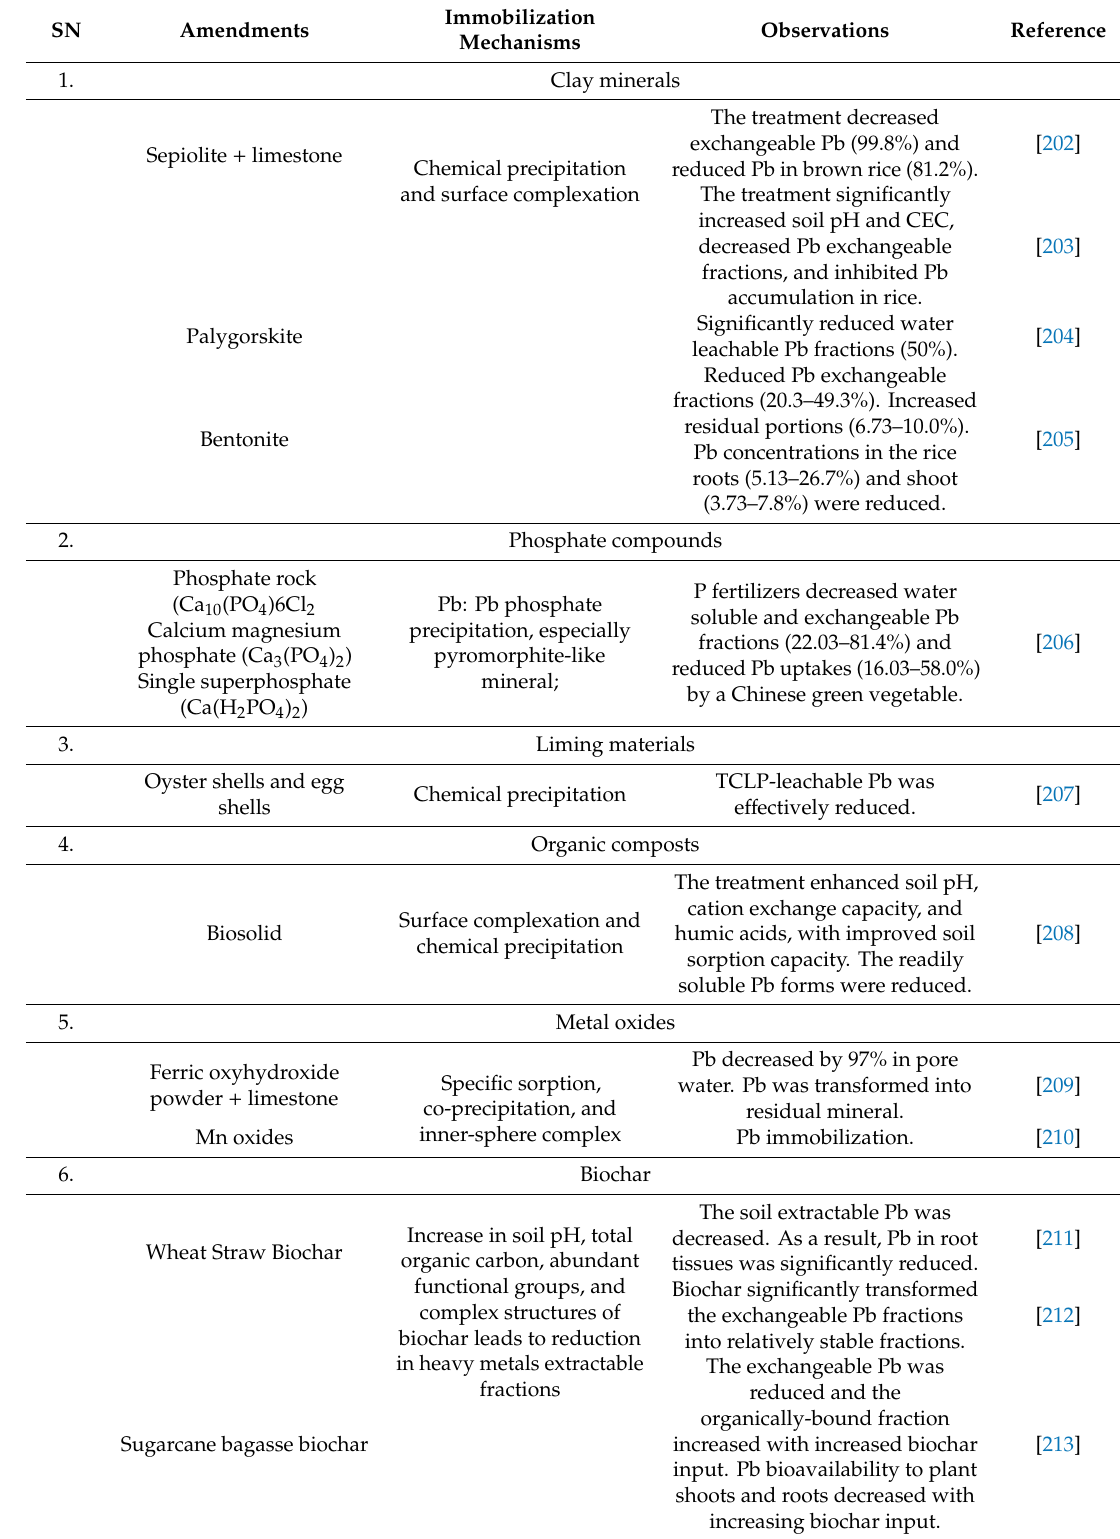
Table 7. Chemical amendments for immobilization of lead in soil and groundwater at the field scale